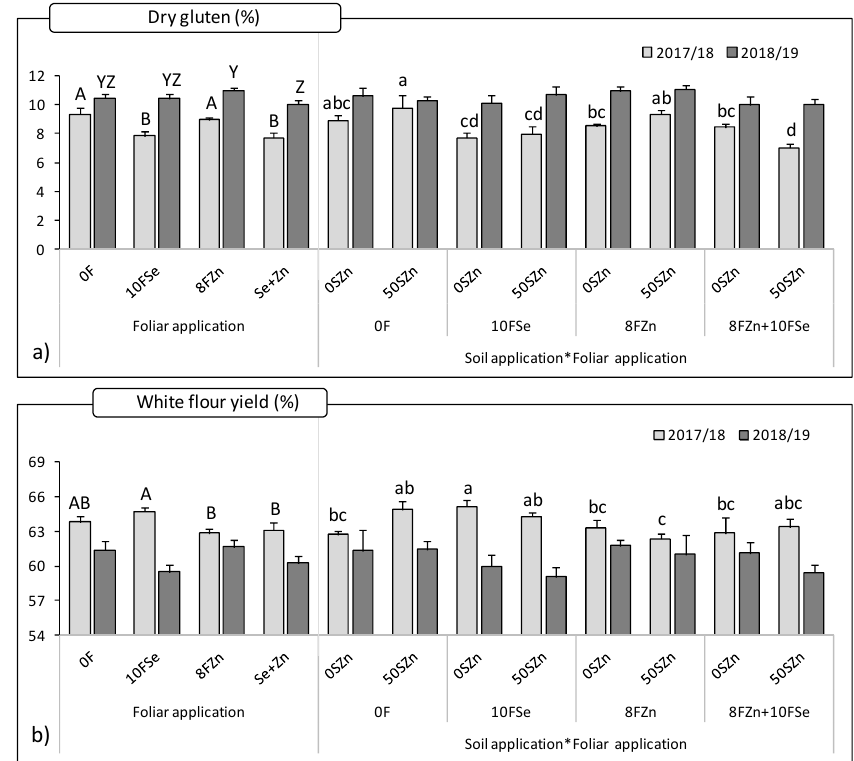
Figure 1. Influence of the foliar application (F) and the F × Soil application (S) interaction on the dry gluten ( a ) and white flour yield ( b ) of the grain in 2017–2018 and 2018–2019. Charts indicate the means ( n = 4), and the error bars indicate the standard error. For each parameter and factor, different letters (if any) indicate significant differences between means according to the LSD test ( p ≤ 0.05). When the molar ratio between phytates and the concentration of each mineral was analyzed, the pattern observed for the influence of the factors considered was exactly the same in the case of Mg and Ca for white flour, and quite similar in the case of Fe (Table 3). Thus, biofortification caused a general increase in this molar ratio in white flour, espe- cially when either Zn or Se was applied alone. Such an increase presented more limited values when both micronutrients were applied in combination (Table 3). In the case of the molar phytate/Mg and phytate/Fe ratios in 2018-2019, there was a significant effect of ei- ther foliar application or theS × F interaction on their values in wholemeal bread and white bread (Table 3). However, differences in the molar ratios between phytates and any of the minerals studied had limited importance. Table 3. Concentration of Mg, Ca and Fe, and their molar phytate:mineral ratios in white flour, wholemeal bread and white bread, expressed as mean value ± standard error ( n = 4 flour and = 2 for bread), as affected by the foliar application (F) and/or by its interaction with soil Zn application. Levels of significance (* p ≤ 0.05, ** p ≤ 0.01, *** p ≤ 0.001) for main effects (Zn soil application and foliar application) and interactions according to ANOVAs are also shown. Study Year